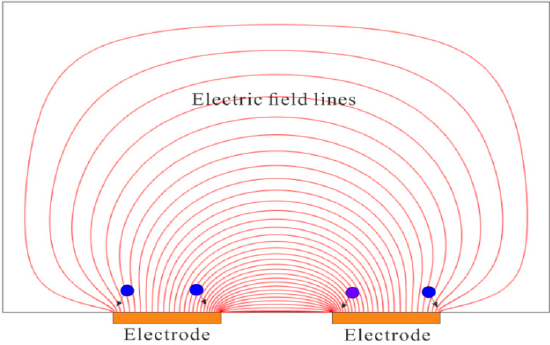
Figure 8. Schematics of dielectrophoretic (DEP) trapping of particles over edges of coplanar electrodes. The density of electric field lines determines the electric field strength, and it is clear that the electric field strength is the highest over the edges of electrodes. Under the effect of positive DEP force, particles would move from the region of low electric field strength (center of electrode) to the region of high electric field strength (edges of electrode).